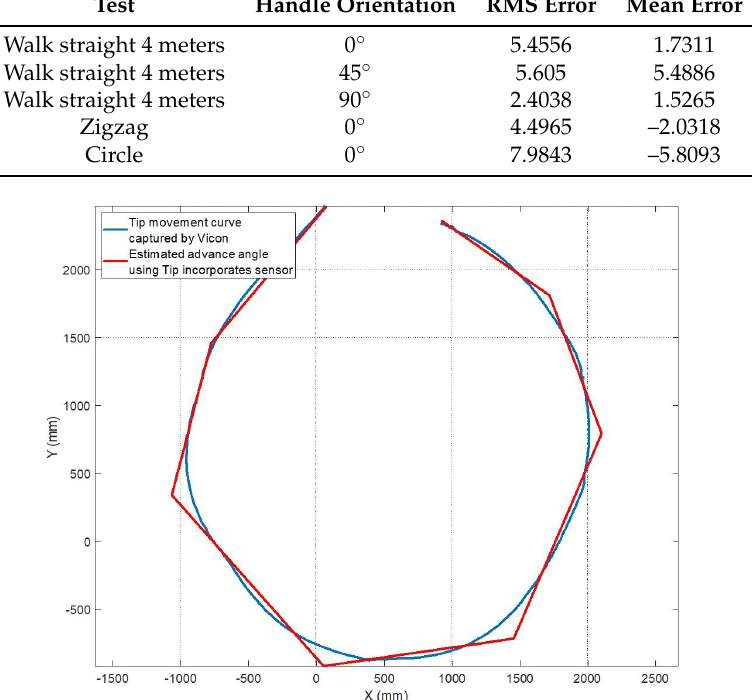
Figure 11. Advance plane estimation in the circular test (Worst Case Scenario) with respect to the real